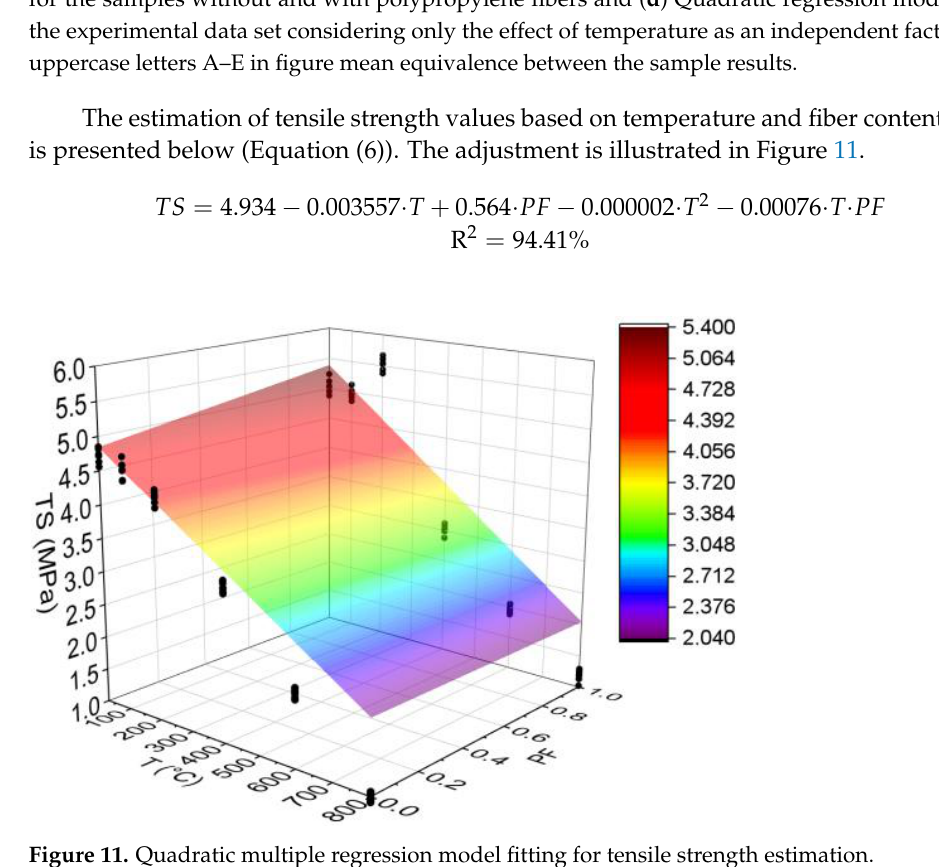
Figure 11. Quadratic multiple regression model fitting for tensile strength estimation.